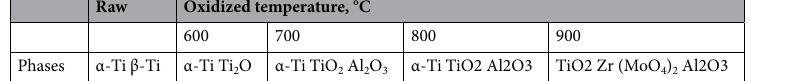
Table 2. Results of the phase composition examination of TC21 Ti-alloy after thermal oxidation.